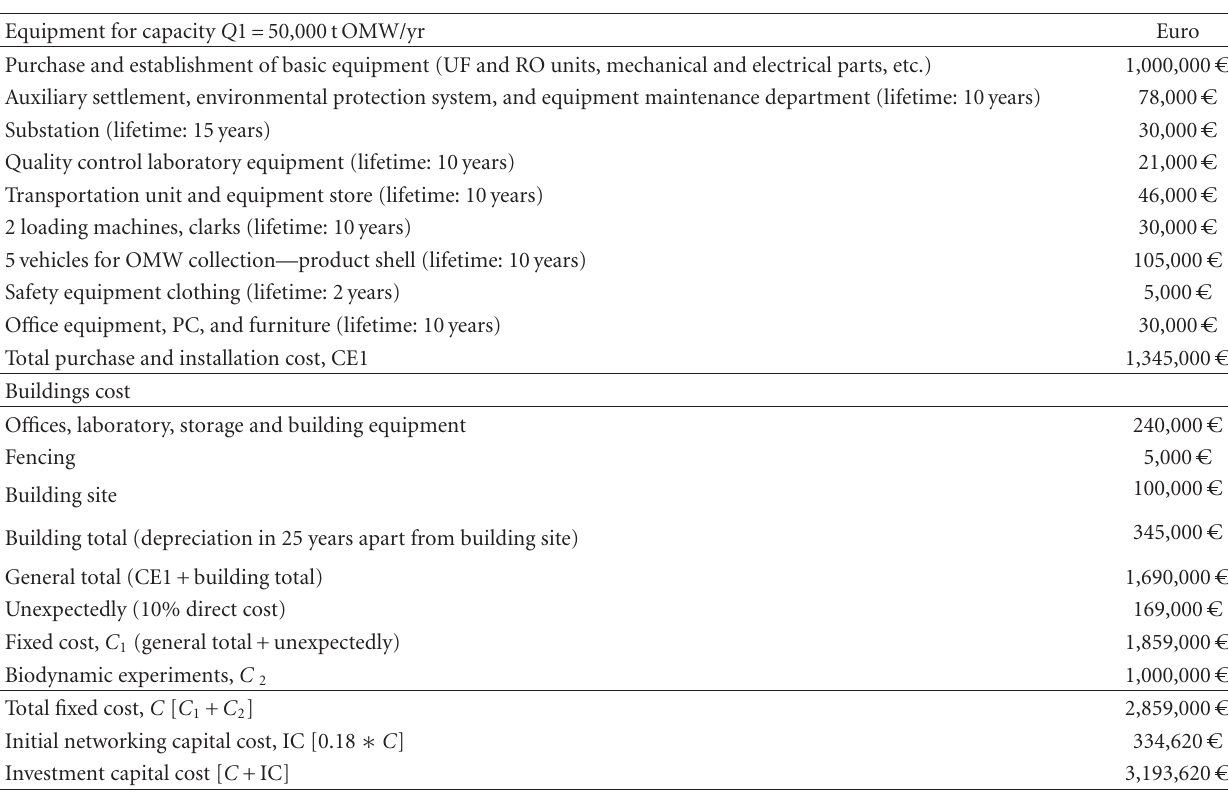
Table 2: Equipment, building, and operational costs for an OMW treatment unit of 50,000 t/yr capacity. Calculations of the fixed cost, initial networking capital cost, and investment capital cost in Euros.